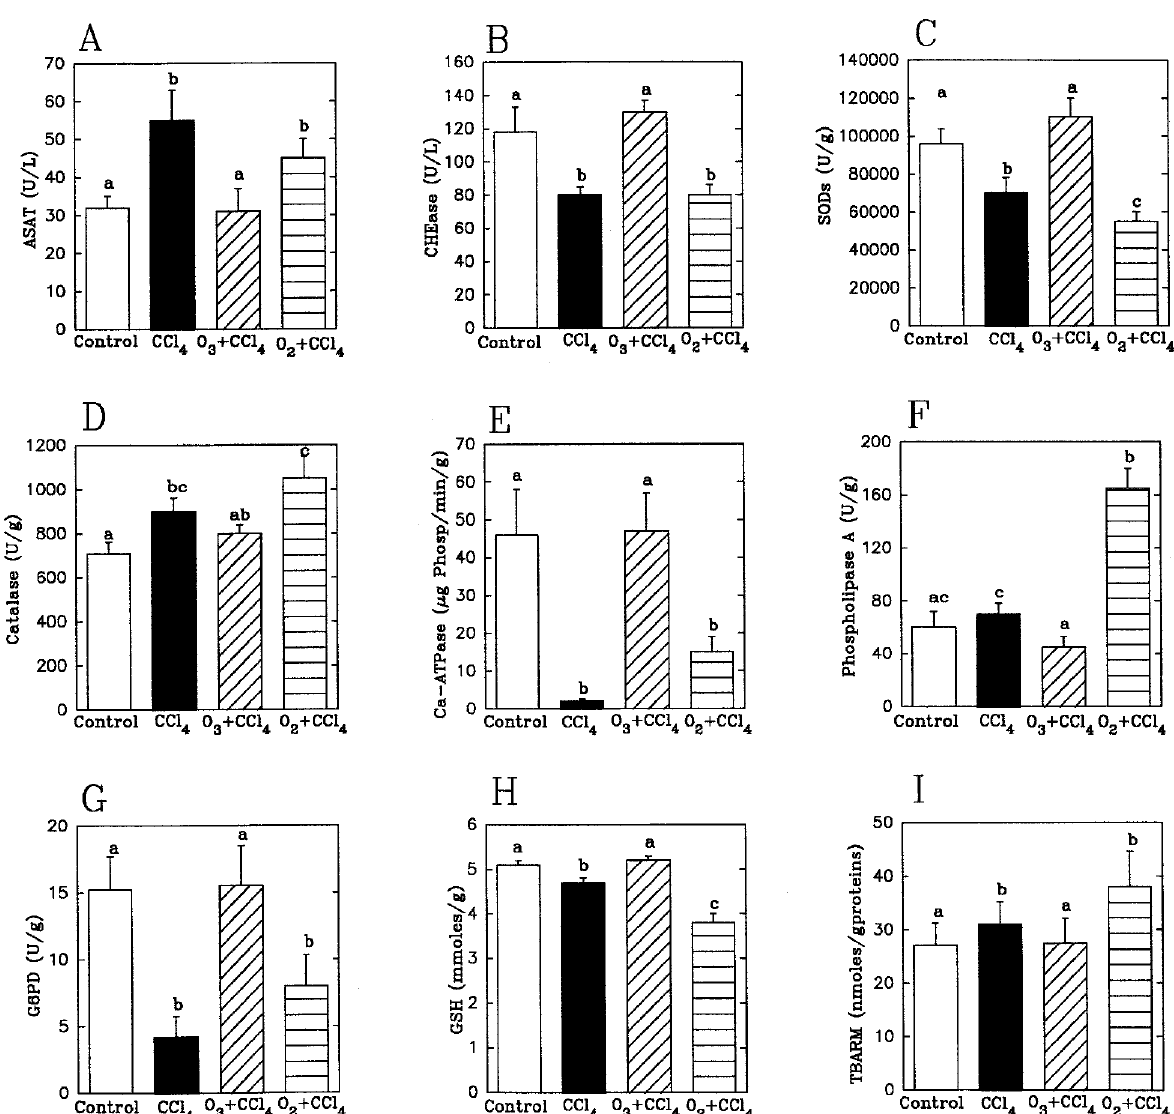
FIG. 1. The effect of ozone oxidative preconditioning in preventing CCl 4 damage in rats. The white and black bars represent either the negative or the positive controls, respectively. The hatched bars represent the situation either after O 3 exposure (diagonal lines) or after O 2 exposure (horizontal lines), respectively, prior to CCl 4 . Values represent mean ±